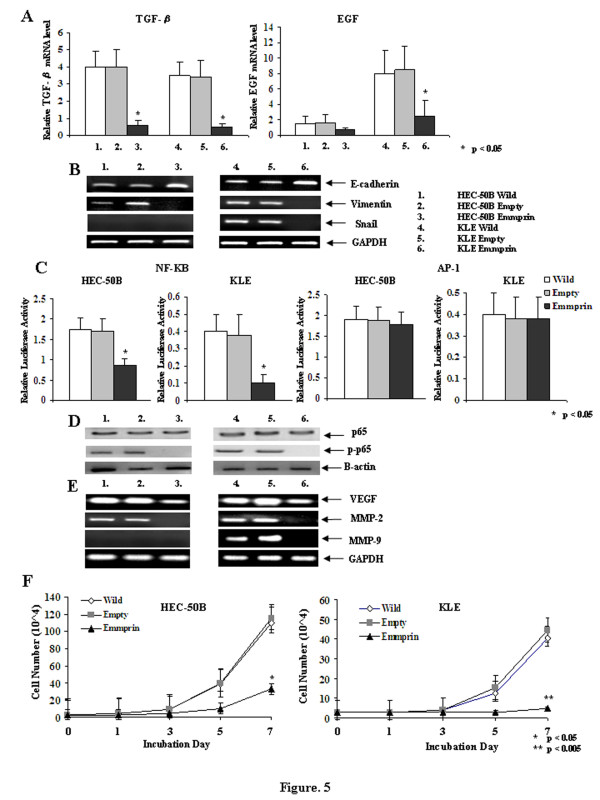
Real-time RT-PCR, quantitative RT-PCR, transient transfection assays, western blotting and cell growth of HEC-50B and KLE cells after transfection with the emmprin siRNA. A) Real-time PCR of TGF-β and EGF expression after transfection of the emmprin siRNA into HEC-50B and KLE cells for 72 h. B) Quantitative PCR analyses of E-cadherin, Vimentin and Snail expression levels after transfection of the emmprin siRNA into HEC-50B and KLE cells for 72 h. GAPDH was used as a loading control. C) Transient transfection assays of NF-κB and AP-1 into HEC-50B and KLE cells after transfection with the emmprin siRNA for 72 h. The assays were carried out for quadruplicate transfection experiments. D) Western blot analysis of NF-κB p65 and p-p65 expression after transfection of the emmprin siRNA into HEC-50B and KLE cells for 72 h. An anti-β-actin antibody was used as a loading control in the same membrane. E) PCR analyses of VEGF, MMP-2 and MMP-9 expression levels after transfection of the emmprin siRNA into HEC-50B and KLE cells for 72 h. GAPDH was used as a loading control. F) Cell growth in monolayers after transfection of the emmprin siRNA. The monolayer growth was evaluated for HEC-50B and KLE cells transfected with the emmprin siRNA and cultured for 1, 3, 5 and 7 days in DMEM or DMEM/F12 medium supplemented with 10% FBS. The numbers represent the data from triplicate experiments.